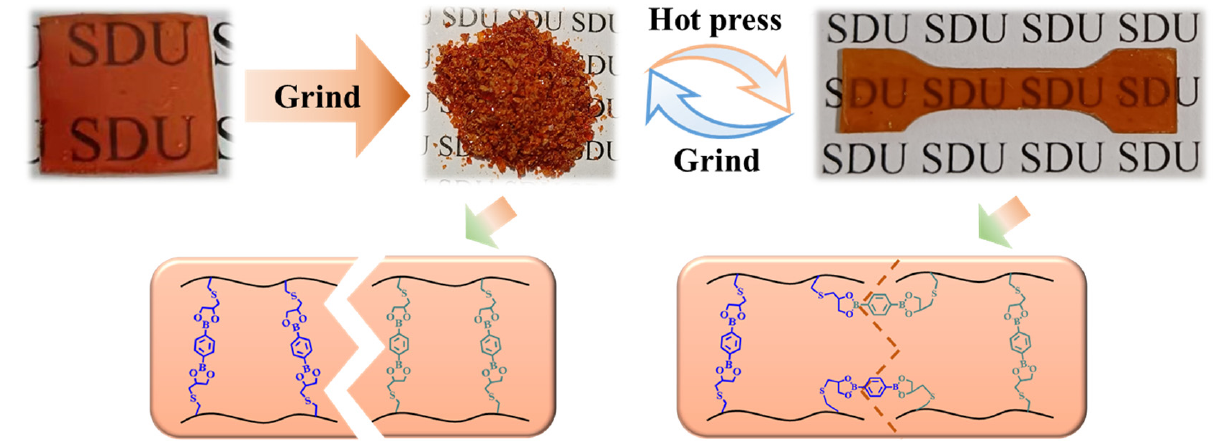
7 of 11 Figure 4. Digital photographs of the reprocessing process and a schematic illustration of the repro-